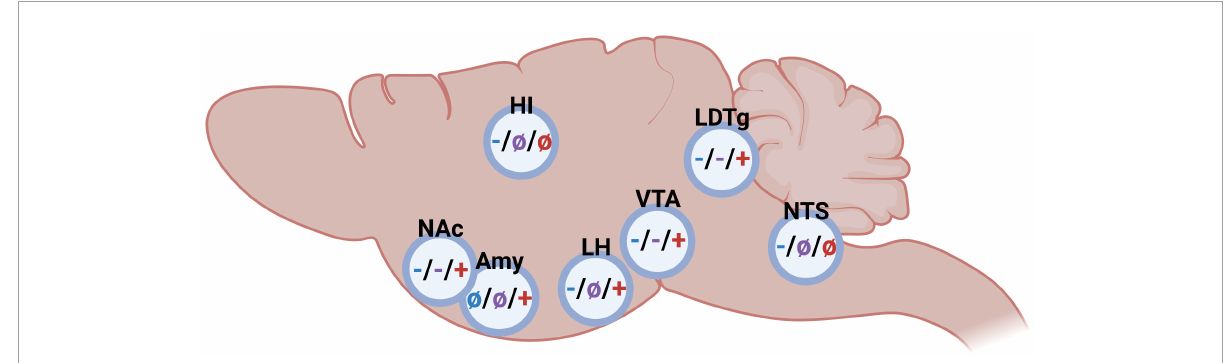
FIGURE2 Schematic illustrations on the impact of glucagon-like peptide-1 (blue), amylin (purple), and ghrelin (red) in different brain regions on alcohol-related behaviors in rodents (– inhibition/decrease; + stimulation/increase, not studied). Nucleus accumbens (NAc), amygdala (Amy), hippocampus (HI), lateral hypothalamus (LH), ventral tegmental area (VTA), laterodorsal tegmental area (LDTg), and nucleus of the solitary tract (NTS). Created by